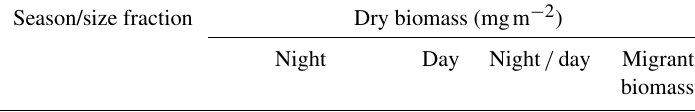
Table 2. A list of mesozooplankton biomass and migrant biomass in various sizes collected from night and day tows, and night / day biomass ratio during different seasons and events. The dry biomass (mgm − 2 ) denotes an integrated biomass through the top layer of